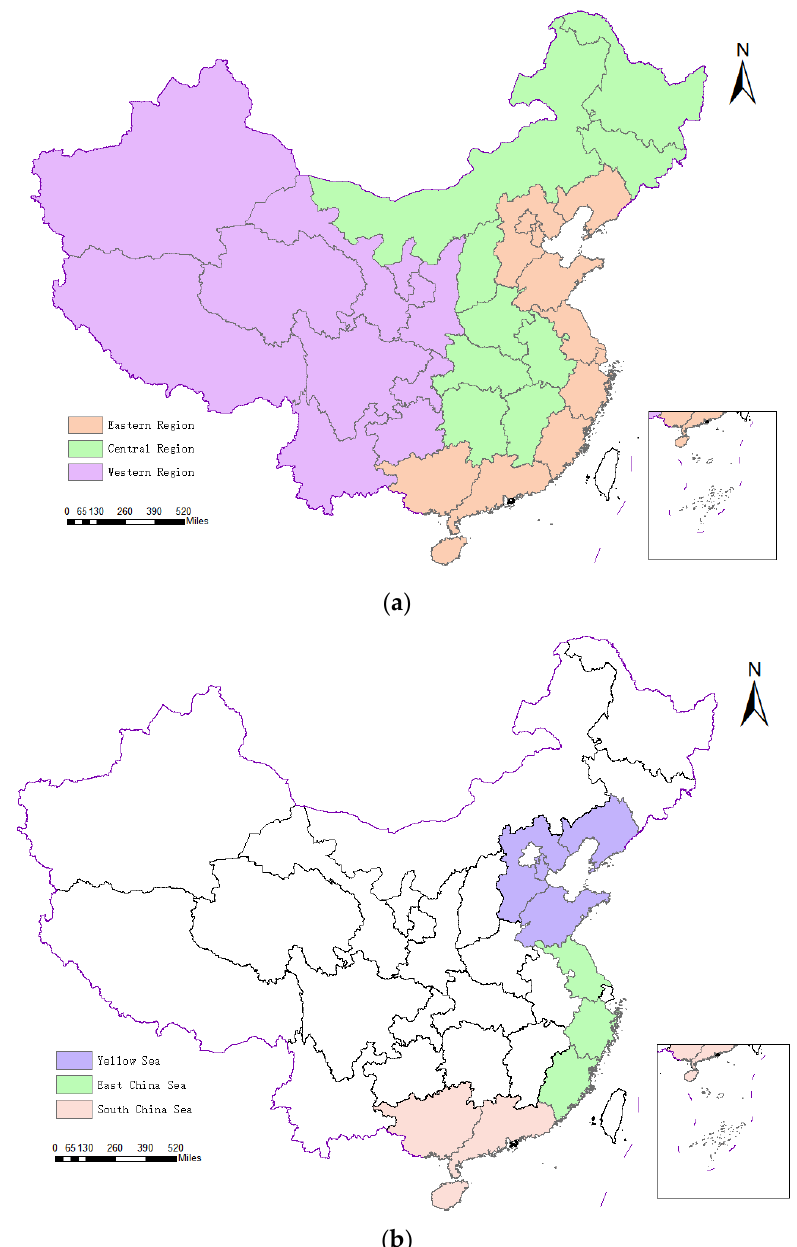
Figure 7. ( a ). Map of provincial division among regions of freshwater aquaculture in China. ( b ).Map of provincial division among regions of mariculture in China.